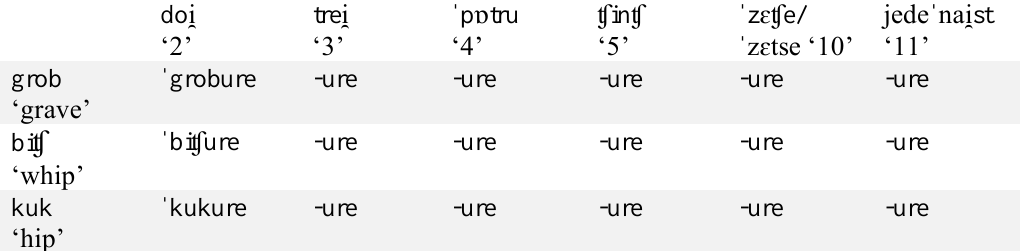
Table 8. Unitary behaviour of some masculines taking -ure